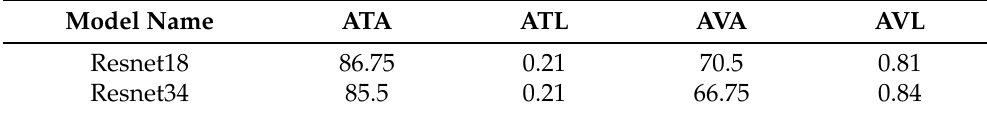
Table 5. General audio classifier